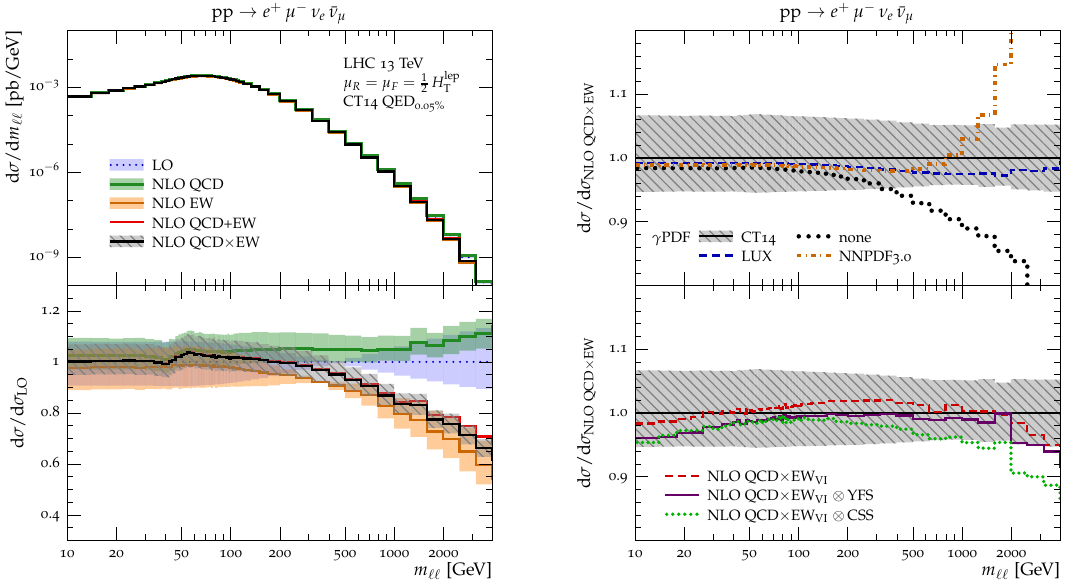
+ (cid:22) (cid:0) (cid:23) ‘‘ , for pp ! e e (cid:22) (cid:23) (cid:22) at 13 TeV.